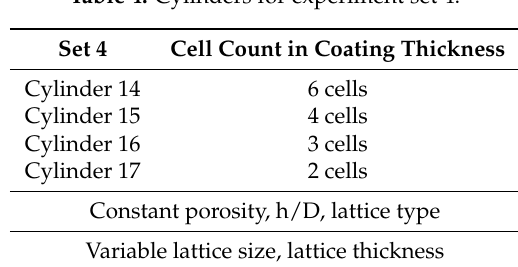
Table 4. Cylinders for experiment set